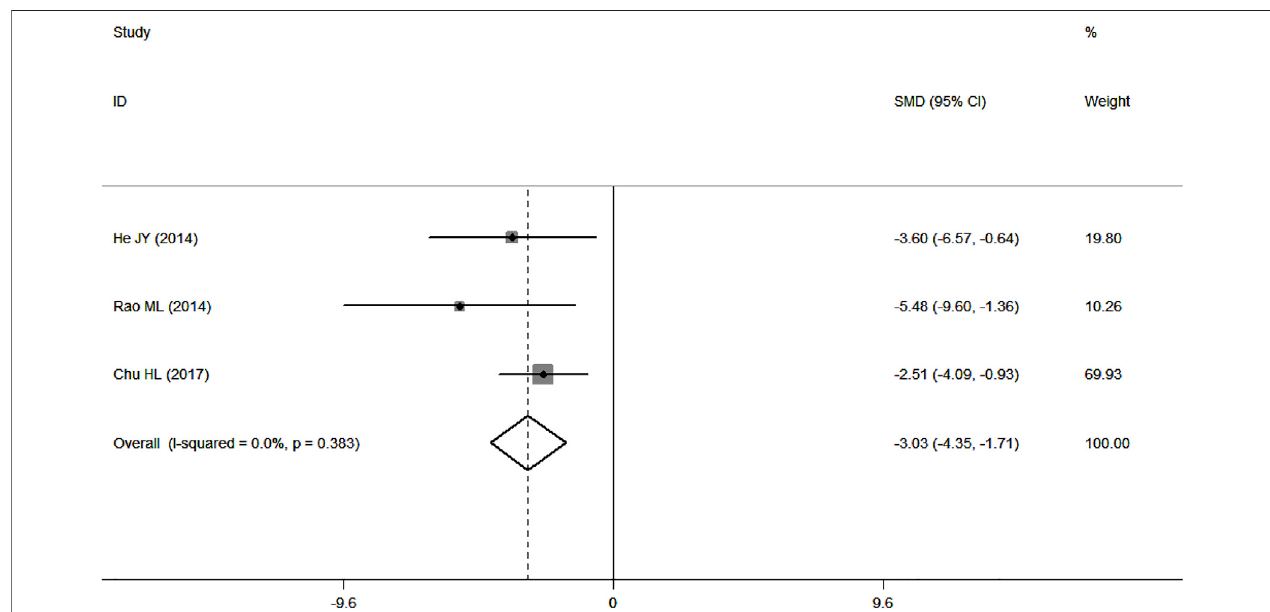
FIGURE 6 | Forest plots of PF for